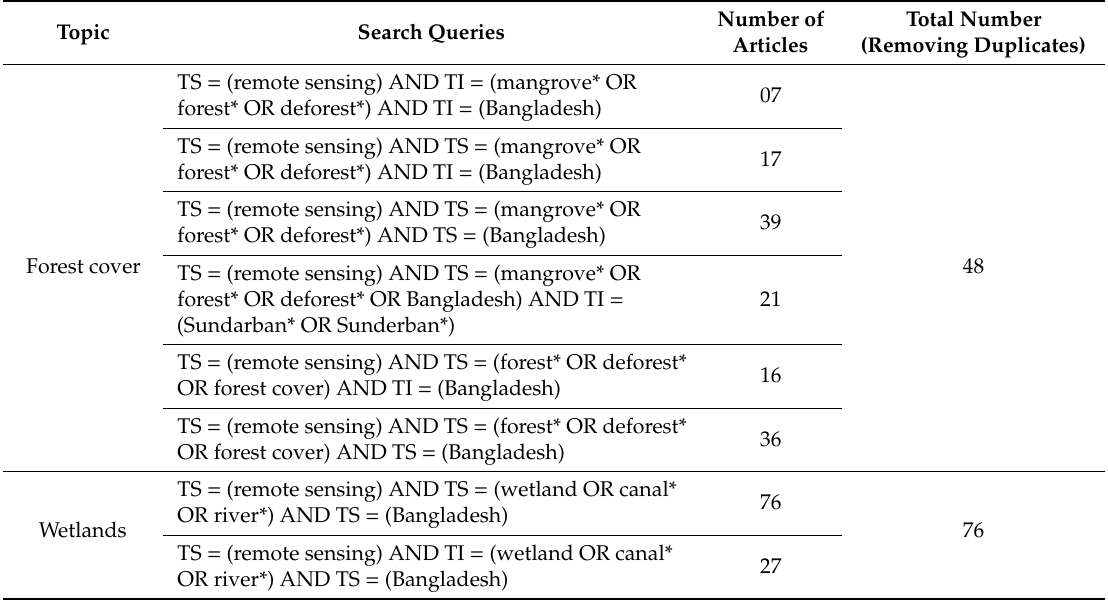
Topic Search Queries